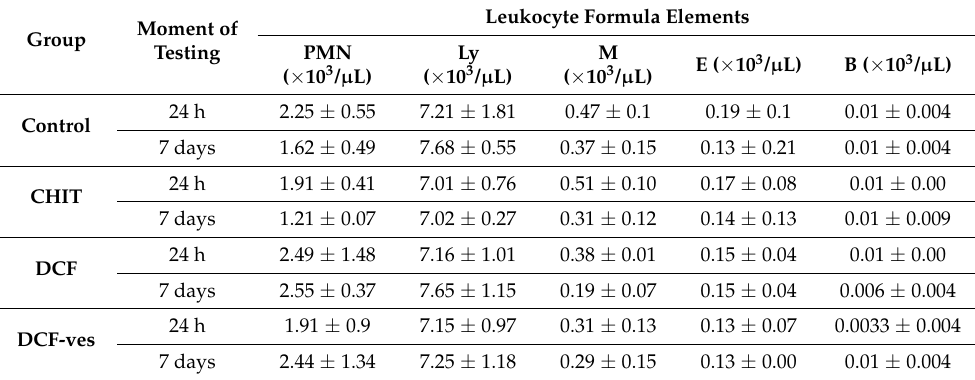
Table 4. Leukocyte formula in animals treated with CHIT, DCF and DCF-ves. Values are expressed as the arithmetic mean ± S.D. of the average number of elements of the leukocyte formula for 6 animals per group.